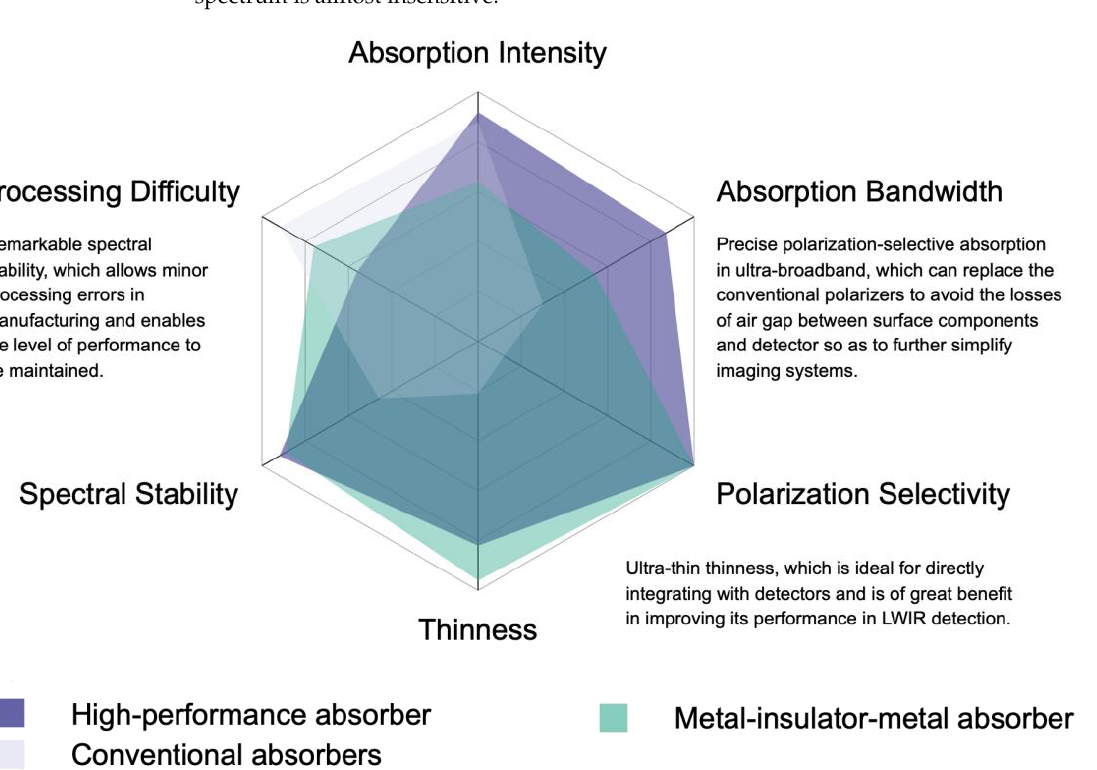
Figure 9. Simulated absorption behavior for absorber as a function of ( a ) width of the wire grating and ( b ) period of the microstructure: as the geometric parameters change, the position of the absorption spectrum is almost insensitive.